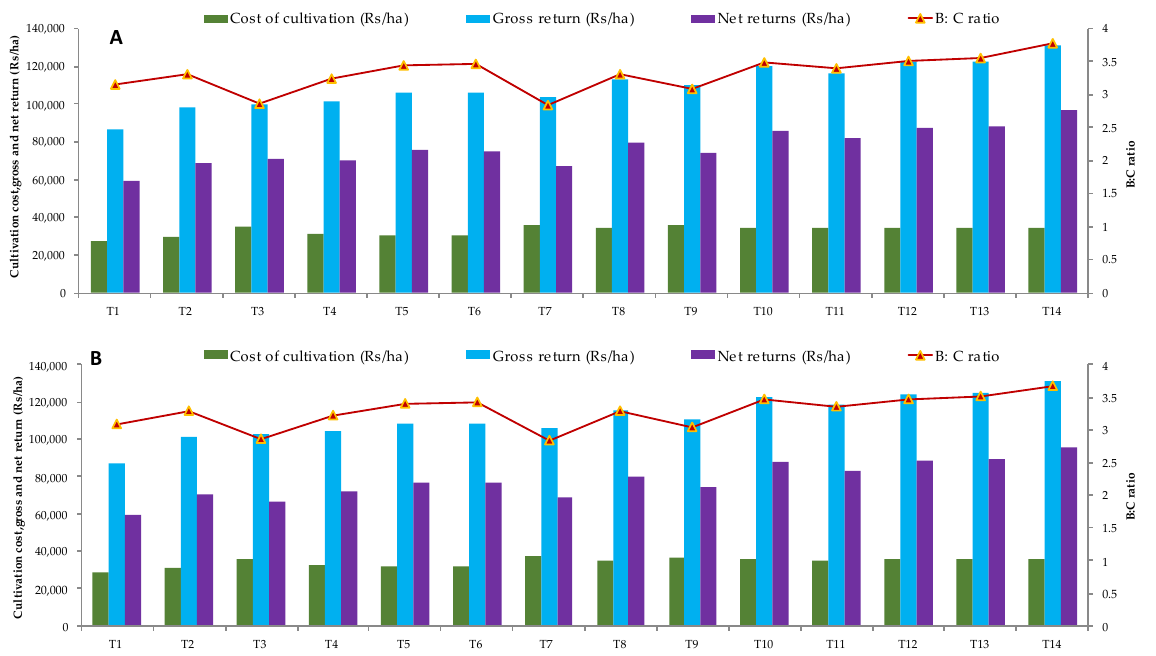
Figure 6. Economic analysis of imposed treatments during 2017 – 2018 ( A ) and 2018 – 2019 ( B ).